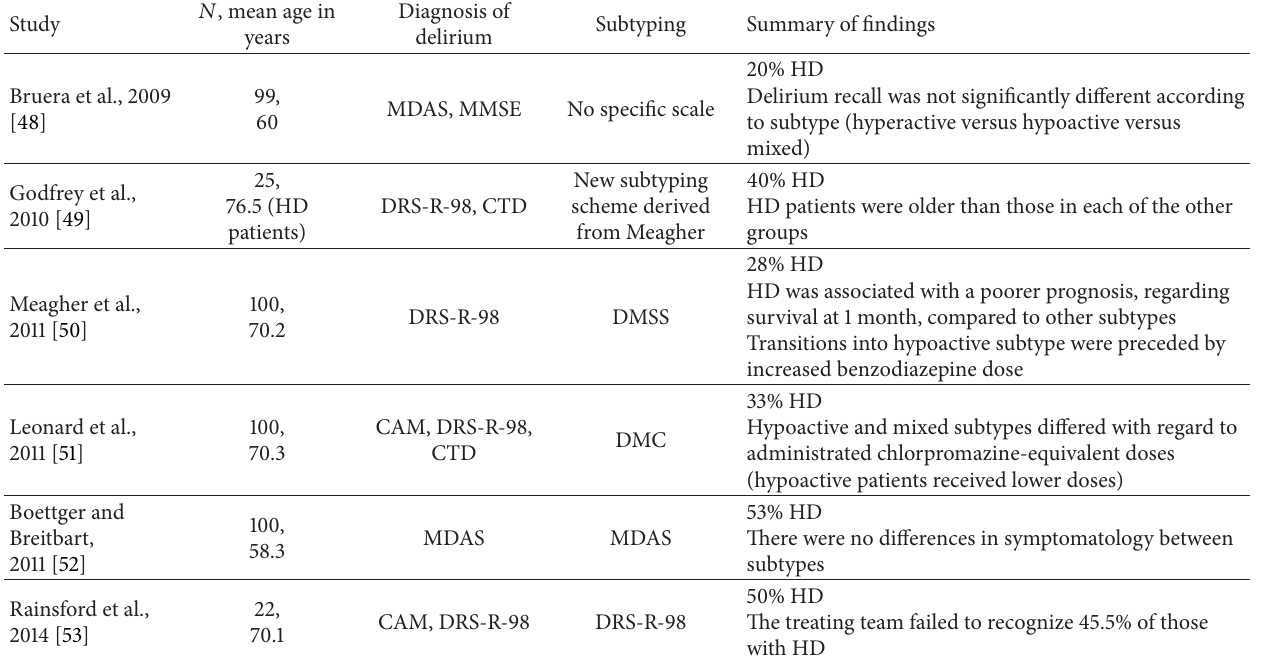
Table 6: HD in palliative